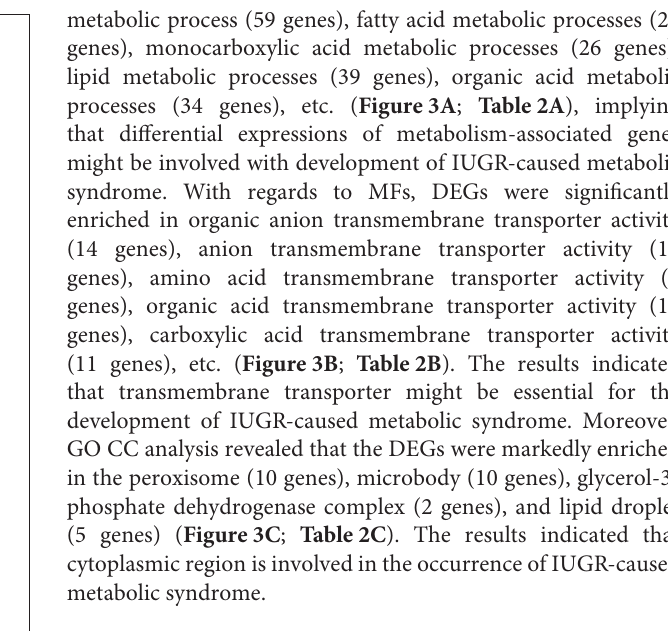
RT-qPCR data analysis: Differences in expression among groups were assessed with Student’s t -test using SPSS